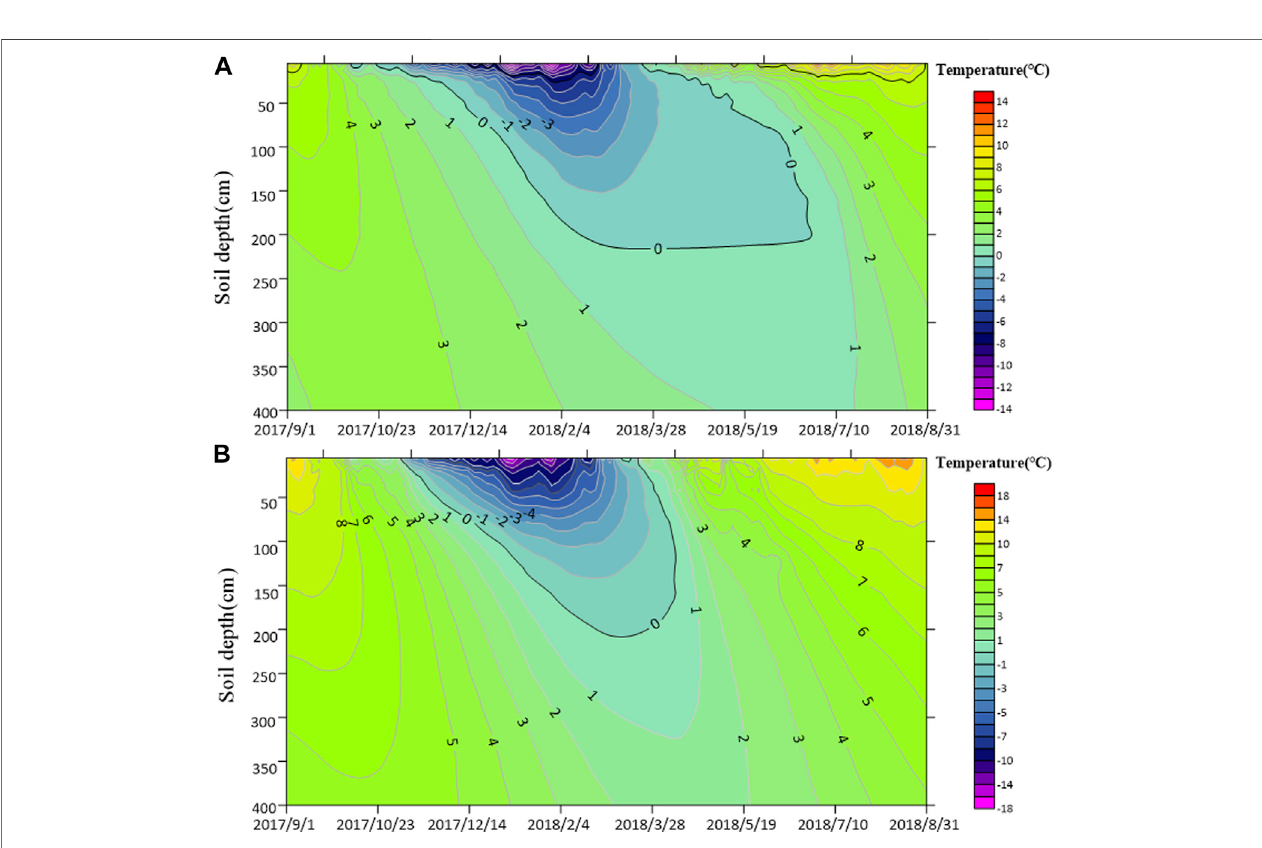
Frontiers in Earth Science |